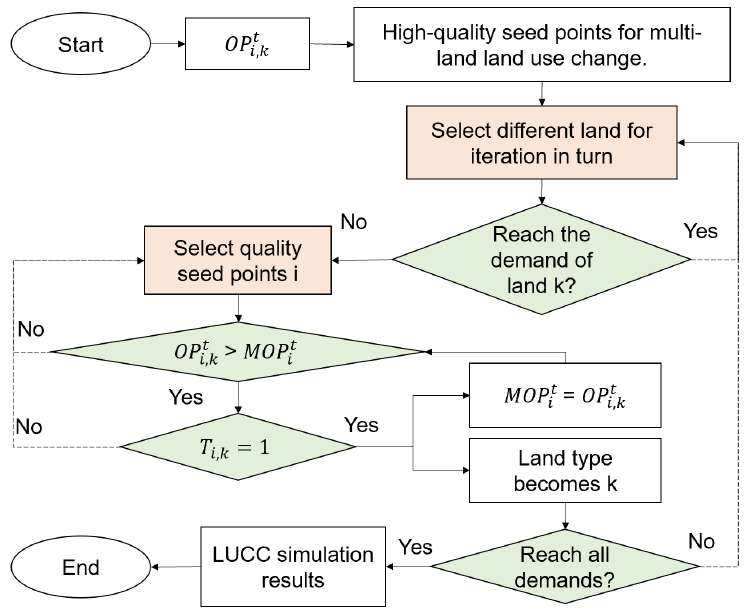
Figure 8. Flowchart of CA model based on high-quality seed selection iterative algorithm